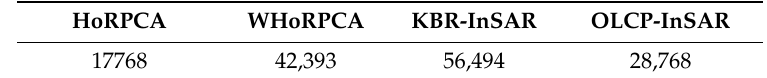
Table 5. Residues remaining in the filtered real InSAR tensor.